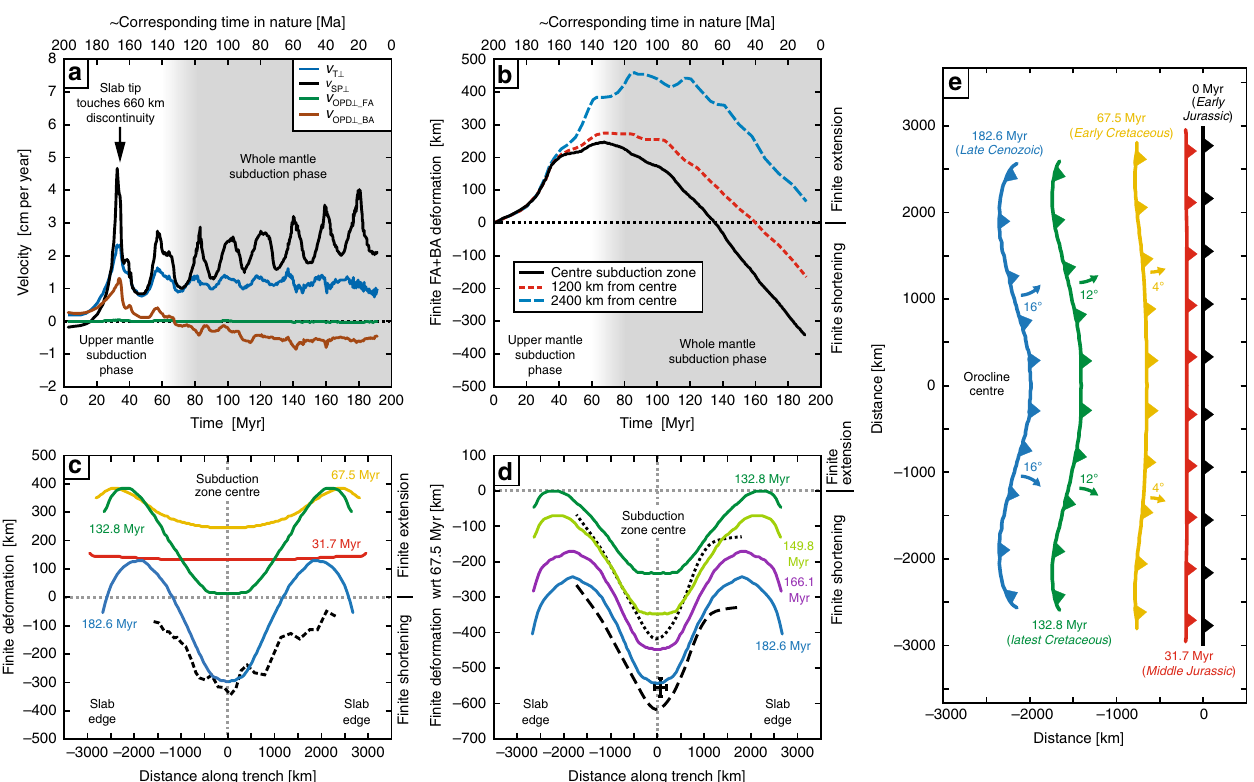
Fig. 3 Numerical results showing the temporal evolution of subduction zone kinematics and overriding plate deformation and trench geometry. a Trench- normal trench velocity ( v T ⊥ , retreat is positive), subducting plate velocity ( v SP ⊥ , trenchward is positive), forearc deformation rate ( v OPD-FA ⊥ , extension is positive), and backarc deformation rate ( v OPD-BA ⊥ , extension is positive) in the subduction zone centre. b Trench-normal fi nite deformation of forearc and backarc in three locations (extension is positive, shortening is negative). Note that the slope of the curves gives the (instantaneous) deformation rate, with a positive slope indicating an extension rate, and a negative slope indicating a shortening rate. c Variation of trench-normal overriding plate fi nite deformation along the trench with respect to 0 Myr (start of model). Black dashed line gives estimated trench-parallel variation in Andean shortening based on crustal thickness 17 . d Variation of trench-normal overriding plate fi nite deformation along the trench with respect to 67.5 Myr (~end of extension phase in centre of subduction zone). Black dotted line gives estimated trench-parallel variation in Andean shortening based on balanced cross-sections and reconstructions 19 . Black dashed line is based on black dotted line but includes ~200 km of additional shortening as documented in the western cordillera 12 , which is postulated to exist all along the coast. Central Andes data point is also plotted 12 . e Evolution of the trench geometry and position. Curved arrows indicate rotation sense and numbers give maximum rotation of the orogen on either side of the orocline centre. Please note that the colour coding in ( c – e ) is related (except for the black America, is added to the curve for Eocene-present shortening (cf. dashed black curve and blue curve in Fig. 3d). The increased possibly represent the underthrusting/subduction of the backarc oceanic basins of the Rocas Verdes Basin and Colombian Marginal Seaway, thereby accommodating several hundred kilometres of shortening.